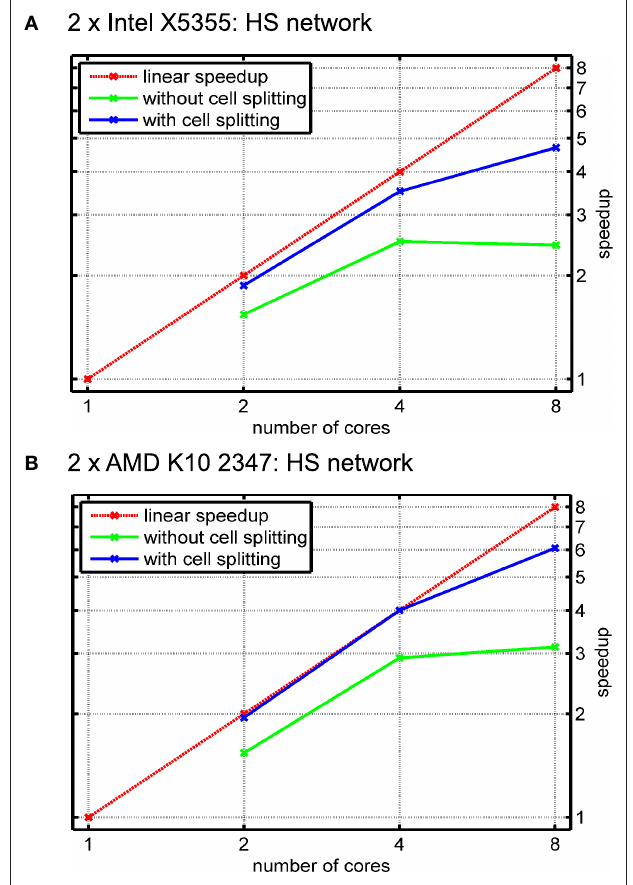
FIGURE 13 | Simulation of the blowfl y’s HS network with automatic cell splitting disabled and enabled. The model was simulated for 100 ms with a time step length of Δ t = 0.025 ms. (A) Speedup results on the Intel test system (see Figure 11A ). Green line shows speedup measurements when the three cells were solved without splitting them; blue line shows results with cell splitting. The relative infl uence of cell splitting increases with increasing numbers of cores. (B) Same as (A) on the AMD test